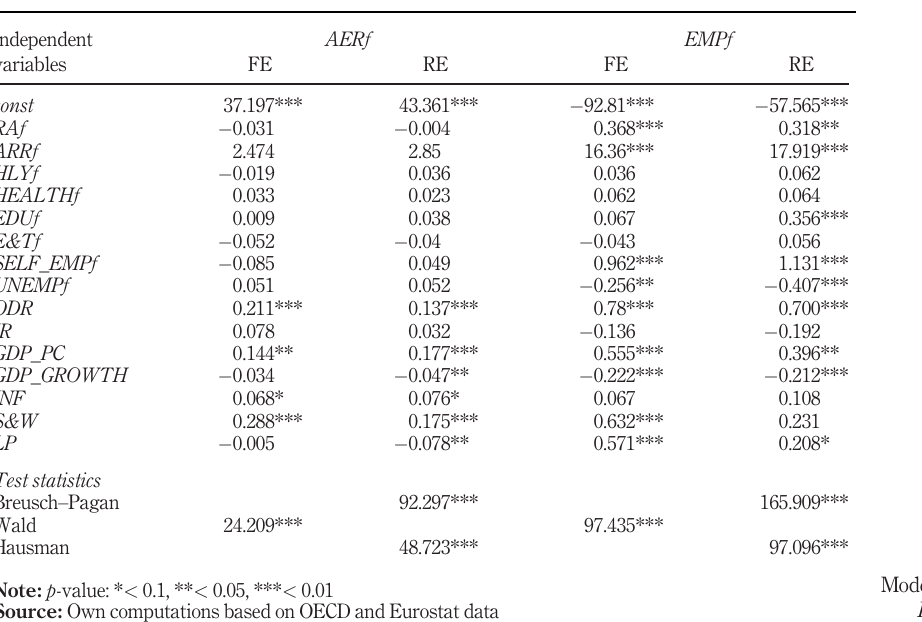
Table 2. Models for AER and EMP ( f